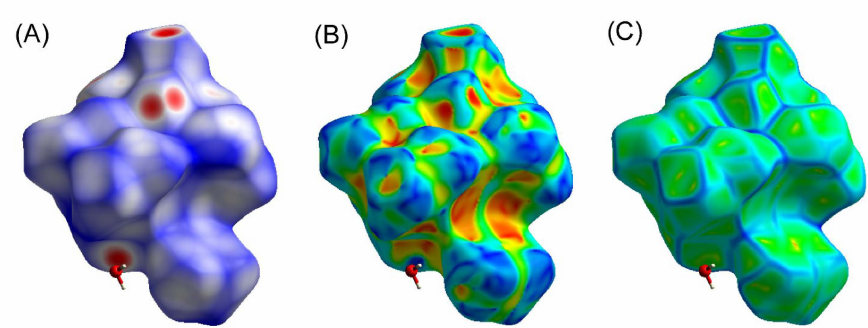
Figure 4. Hirshfeld surfaces of 1 mapped with d norm ( A ), shape index ( B ), and curvedness ( C ). Figure 5 displays the fingerprint plots, split into atom pair close contacts. This analysis permits the distinction of contributions from different interactions, which overlap in the full fingerprint. For 1 , the proportions of the H ... H, O ... H, C ... H, and N ... H interactions comprised 39.50%, 7.20%, 15.40%, 10.20%, and 37.10% of the total Hirshfeld surface of each molecule, respectively.